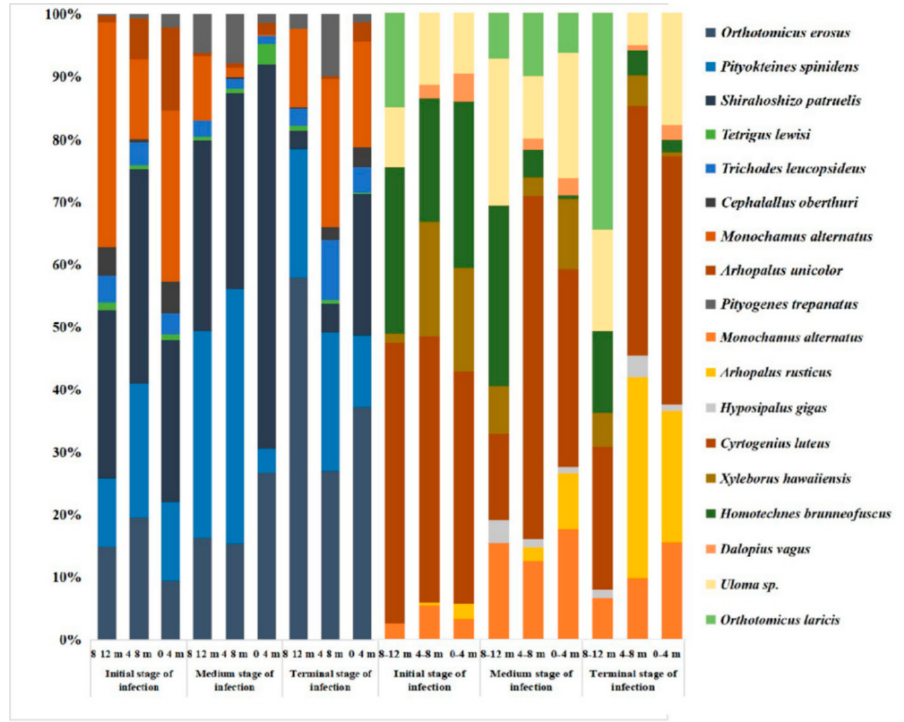
Figure 5. Composition of xylophagous beetles in the upper, middle, and bottom positions of P. thun- bergii and P. massoniana infected by PWN at different